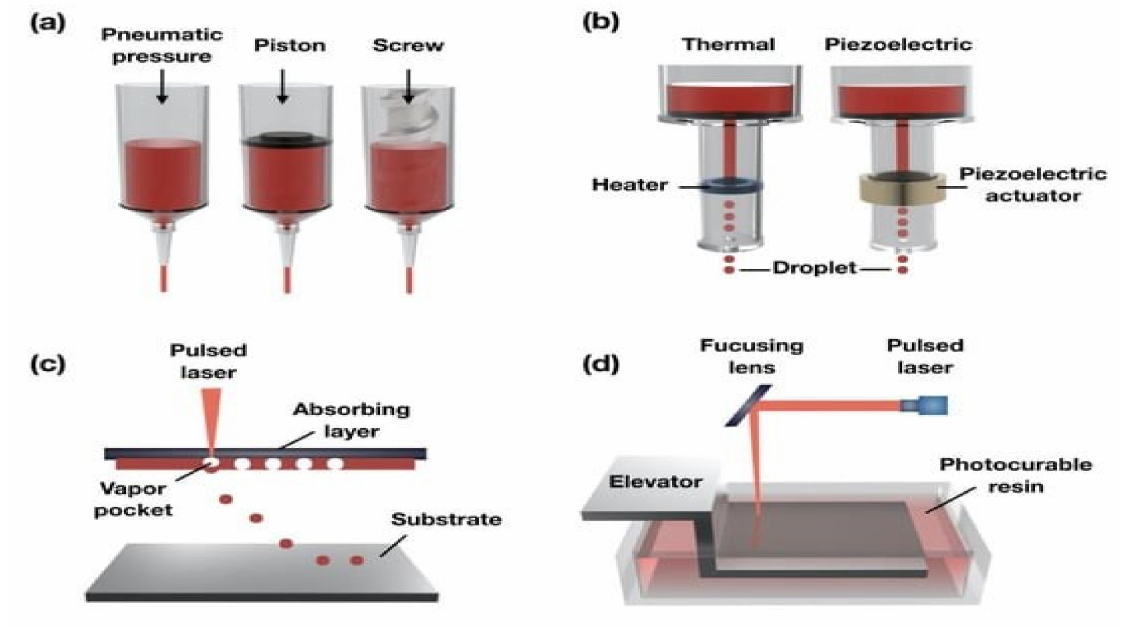
Figure 5. Schematic representation of primary bio-printing methods ( a ) extrusion-based, ( b ) ink-jet, ( c ) laser assisted, and ( d ) stereolithography. Reprinted with permission from [144]. Copyright 2020, MDPI. Distributed under Creative Commons Attribution—based license (CCBY